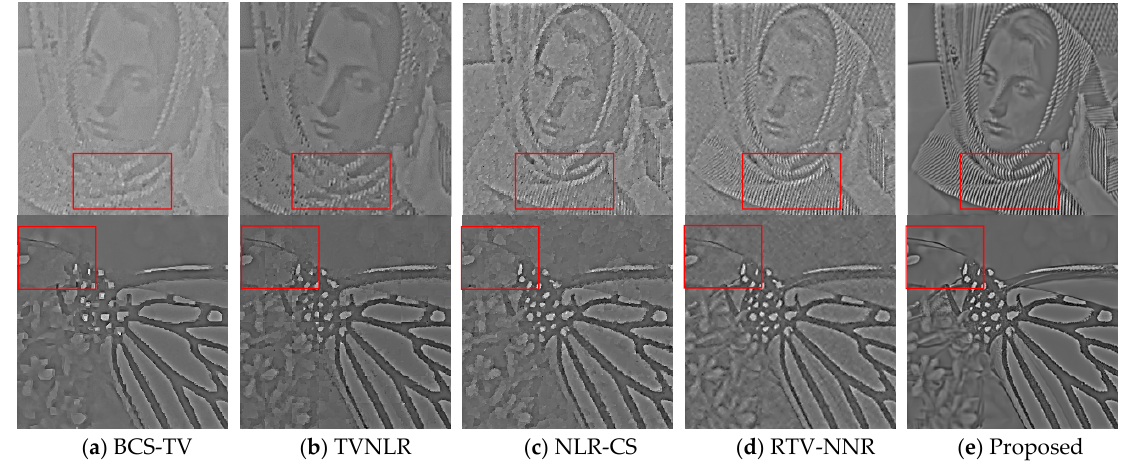
Figure 8. The texture details of reconstructed images obtained by five methods.